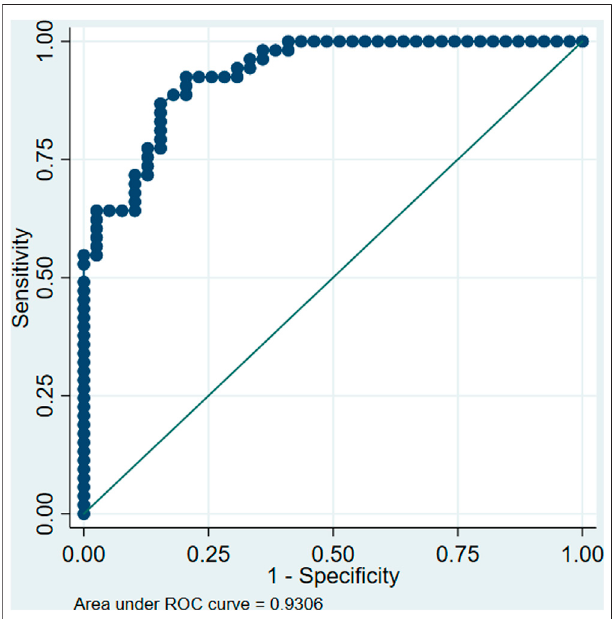
FIGURE2| ReceiverOperatingCharacteristic(ROC)curveforthemodel proposed to predict infections in patients undergoing cytotoxic chemotherapy. (ReferencesTLR2TA/AA, IL6GG,OAT4AA,ABCC2 CC/CG, CYP3A4 TT and CT, Female sex, 60 years or older,